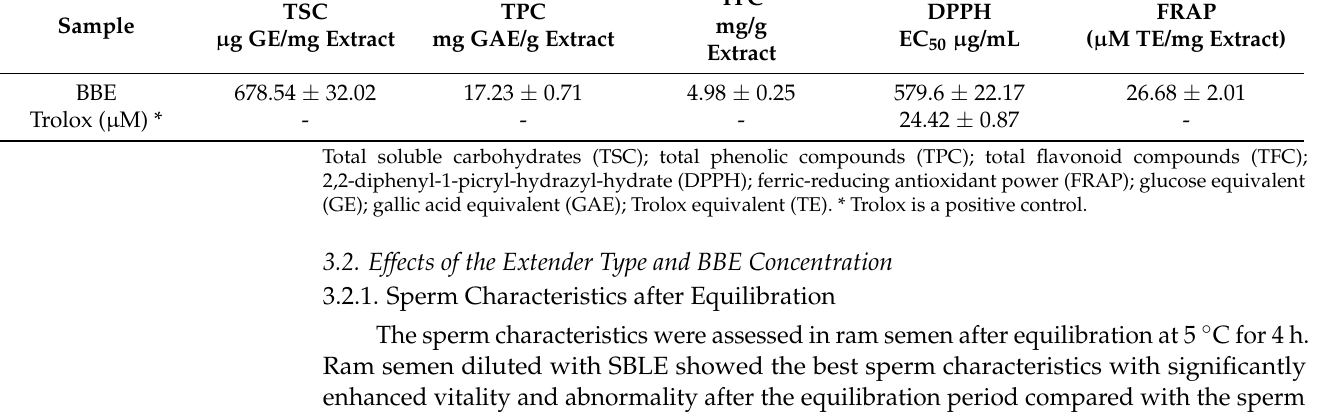
Table 1. Composition and antioxidant activities (means ± SD) of bee bread extract (BBE).